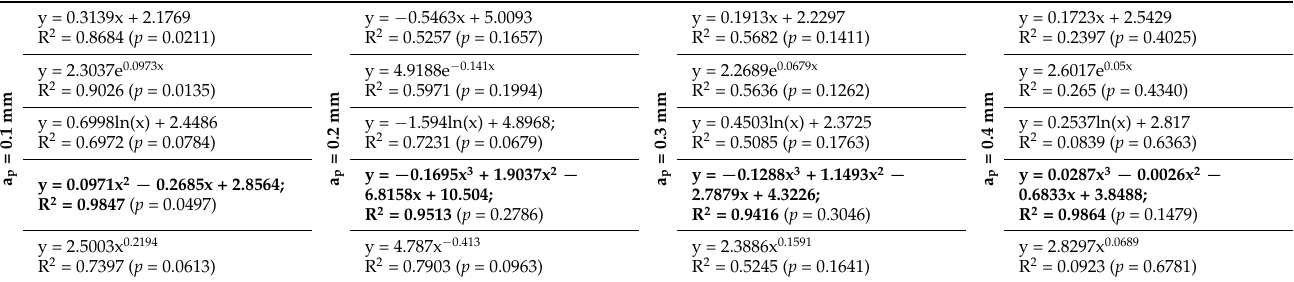
Table 7. Results of mathematical modelling of the Sku parameter as a function of the feed rate for different values of the depth of cut (regression functions y = Sku(f z ); f z = x with the coefficient of determination R 2 ).